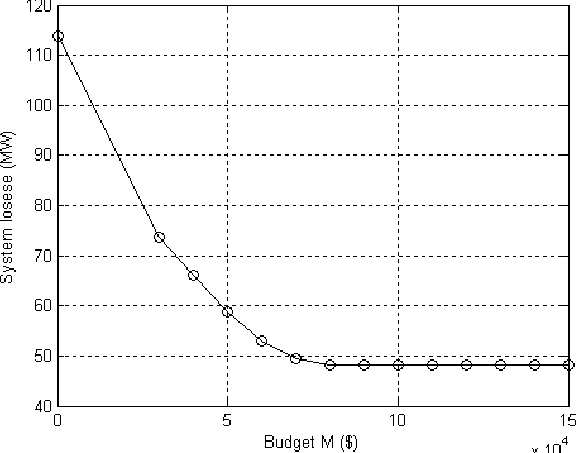
Figure 7. Relationship between the system losses and various budget examples of investment on the IEEE 118-bus system. Table 13. Transform the test results into the classical objective values on the IEEE 118-bus system. Budget